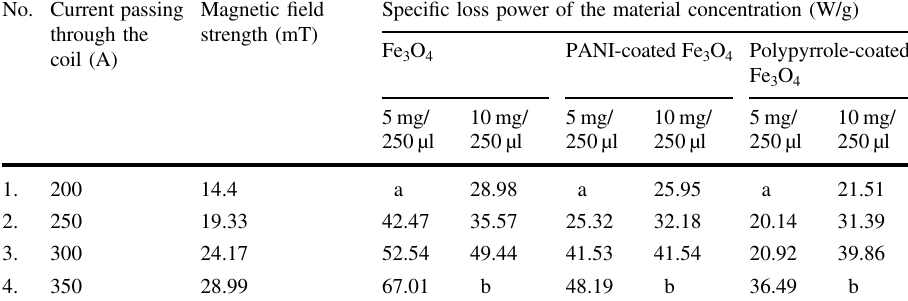
No. Current passing Magnetic fi eld through the strength coil (A)